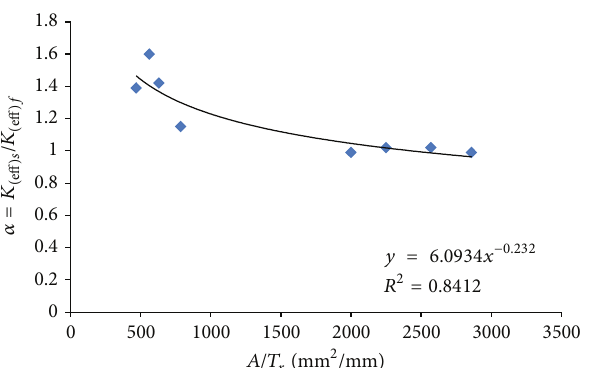
Figure 5: Suggested correction factor for horizontal stiffness for fiber mesh-reinforced bearings at 100% strain